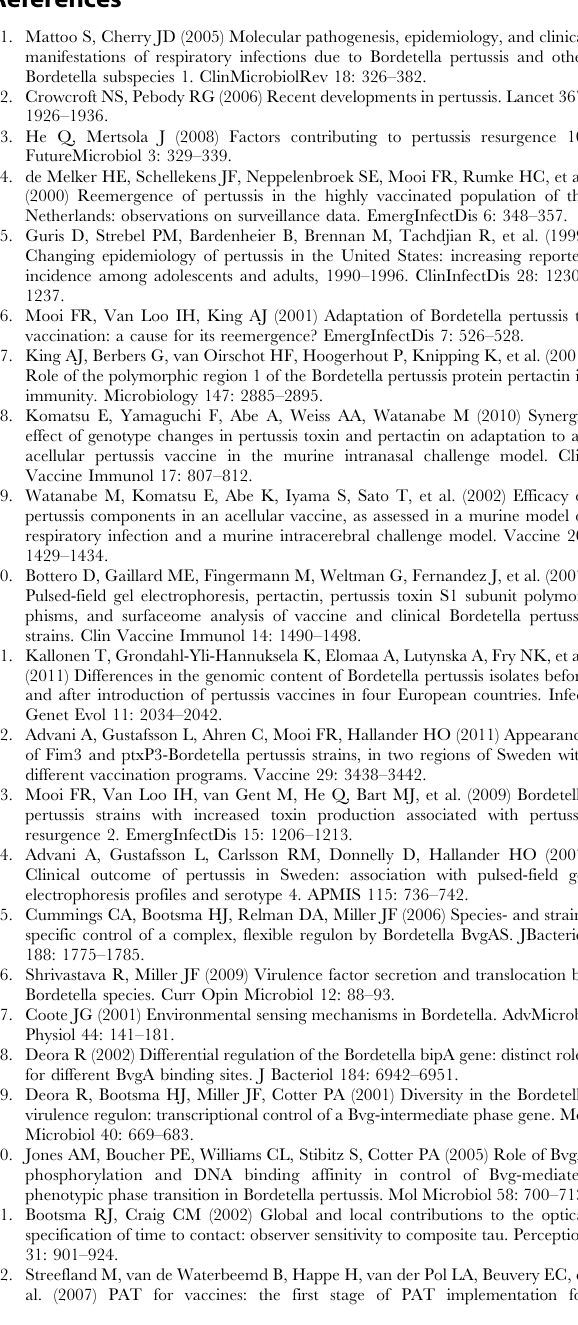
Table S2 Summary of all genes significantly up or down regulated in strains carrying the ptxP3 allele compared to strains with the ptxP1 allele. The gene ID, gene name and gene category are shown. Table S3 Quantitative PCR Primer sequences for genes by Q-PCR in this study . Primer sequences for 6 assays: 5 target